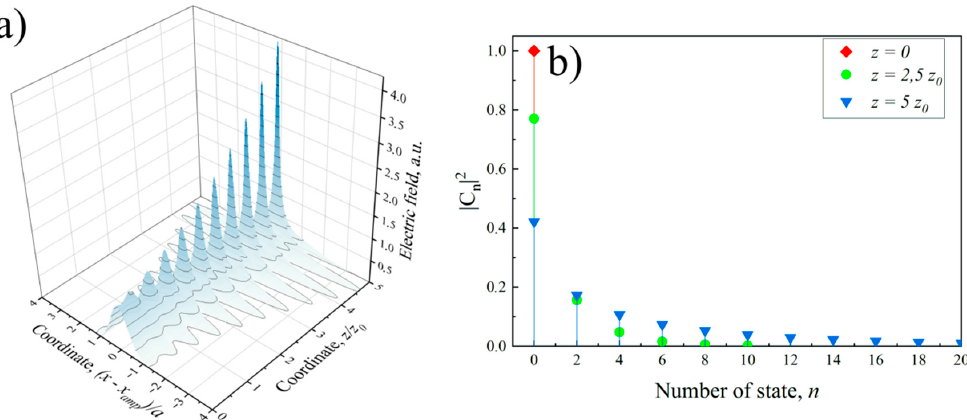
Figure 5. Excitation of the spatially squeezed vacuum coherent state of the beam propagating in the waveguide modulated along the propagation direction susceptibility. ( a ) Squared amplitude of the electric field strength. ( b ) Distribution over stationary states for different lengths of propagation for z / z 0 = 0; 2.5; 5, z 0 = 2 π / K , parameter Θ sq = 2 π k γ 2 a 2 z 0 / x 2 0